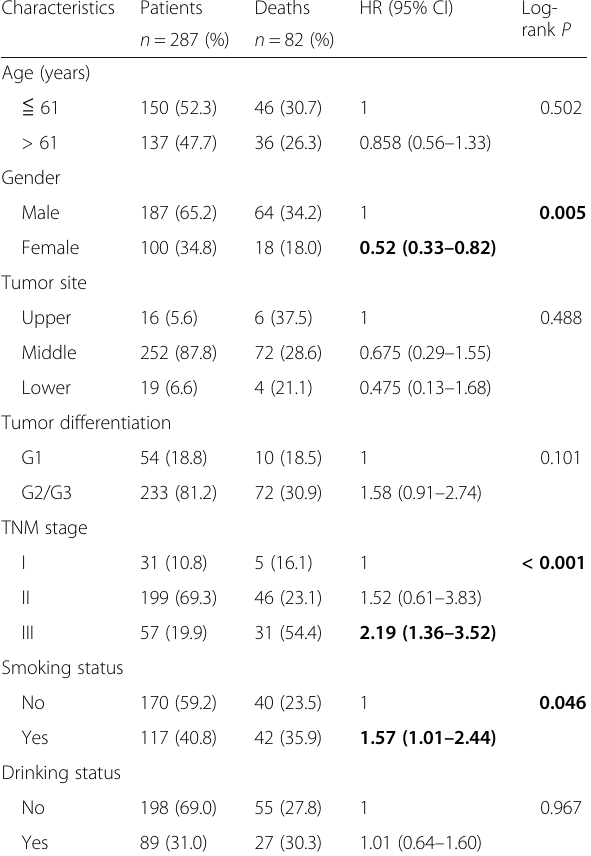
Table 1 Univariate analysis of clinical characteristics associated with post-operational overall survival in ESCC patients